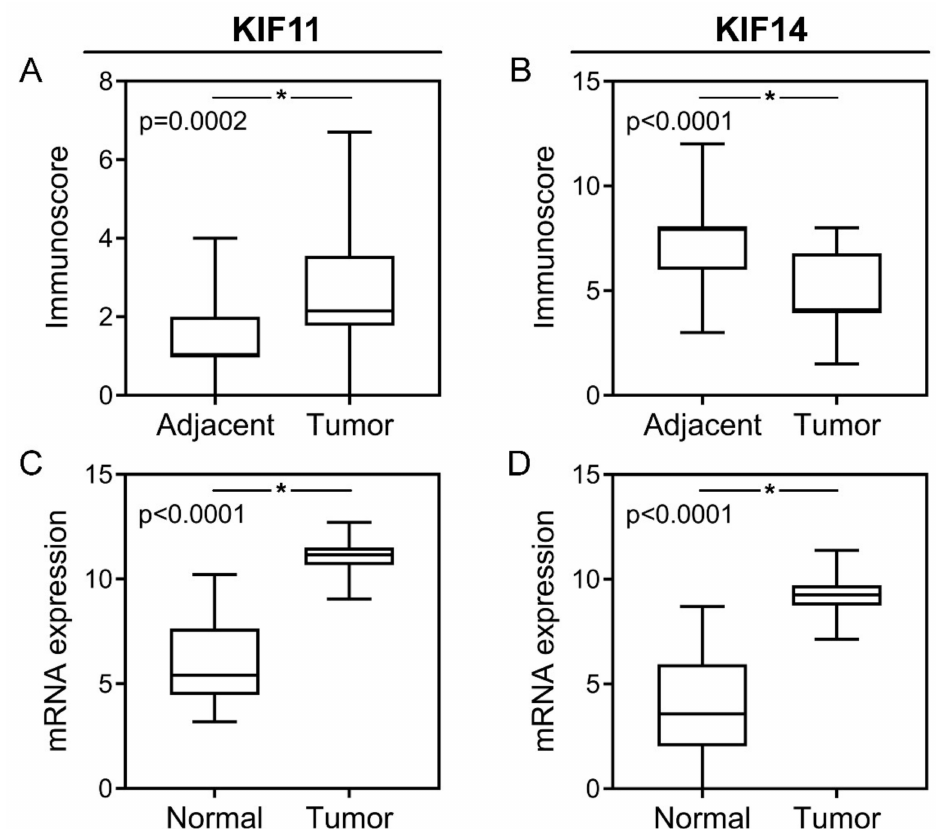
Figure 2. Protein and mRNA expression of KIF11 and KIF14 in colorectal cancer. KIF11 ( A ) and KIF14 ( B ) protein expression levels in CRC tumors compared to noncancerous adjacent tissues; KIF11 ( C ) and KIF14 ( D ) mRNA expression levels in CRC tumors compared to normal tissues. The error bars present the range from minimum to maximum values of data. Asterisks (*) indicate statistically significant differences ( p <